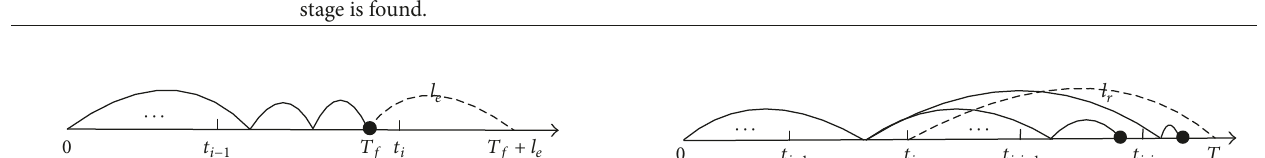
Figure 3: A delayed failure replacement with a regular ordered